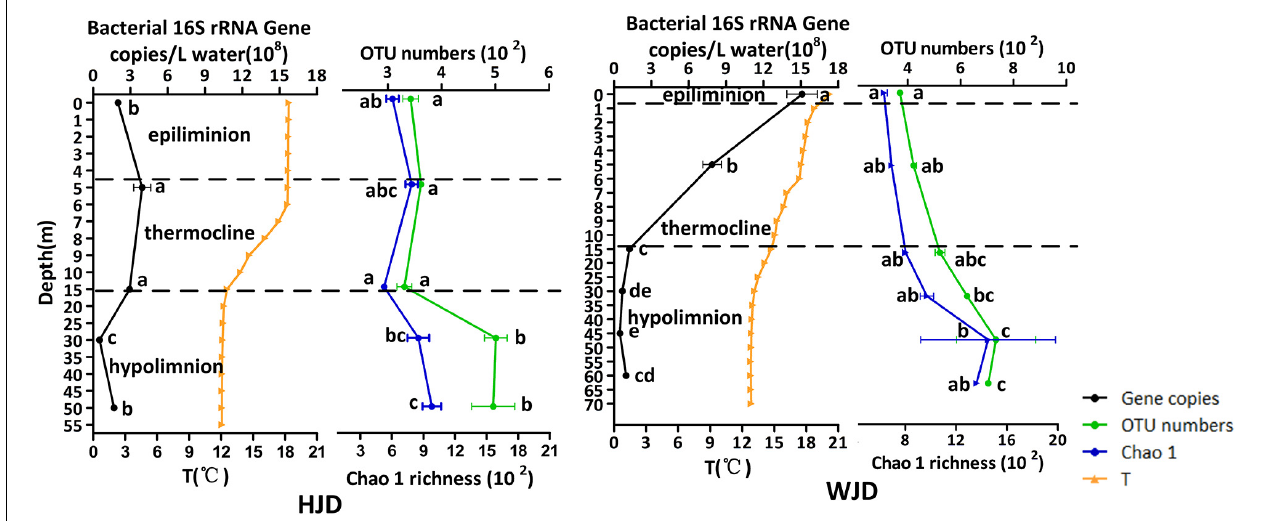
FIGURE 2 | Variations in bacterial abundance, operational taxonomic units (OTUs), Chao1, and water temperature (T) at different water depths in Hongjiadu (HJD) and Wujiangdu (WJD) reservoirs. Error bars represent standard deviation of the mean ( n ≥ 2). Different letters above the columns indicate significant differences at p < 0.05. TABLE 1 | Correlation analysis of water bacterial abundance, diversity indexes with the environmental factors.